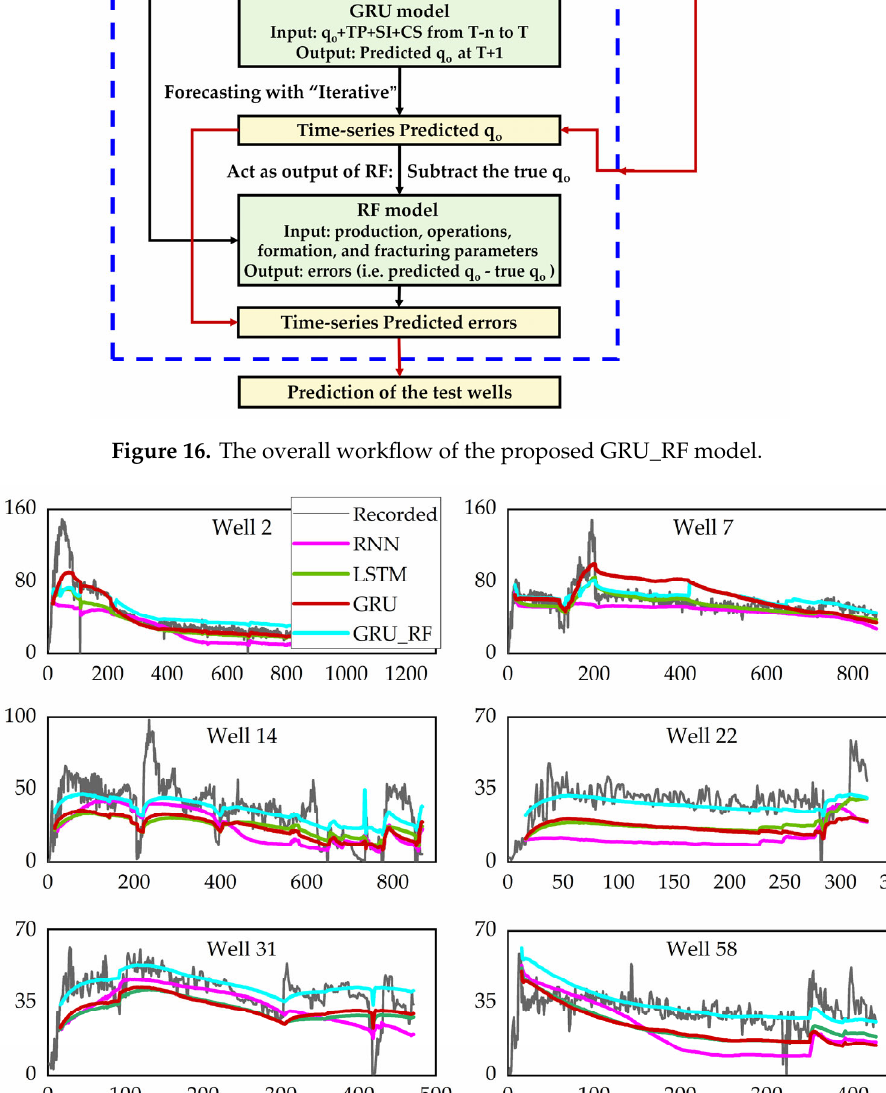
( b ) Figure 18. Comparison of prediction performance of RNN, LSTM, GRU, and GRU_RF on test wells with two evaluation indices: ( a ) RMSE; ( b ) MAE. The proposed model has advantages over traditional DCA and conventional time ‐ series prediction methods. Firstly, it can be applied to new wells with production time of over 2 weeks. For